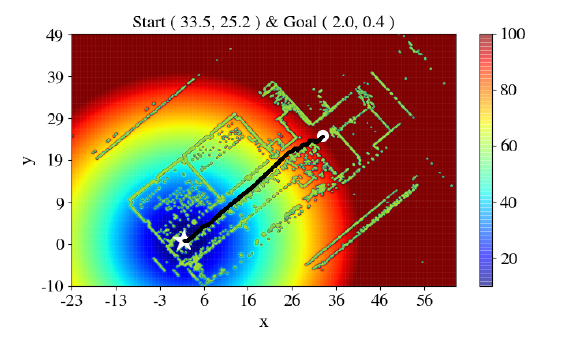
Figure 13. Non-discretized potential map.